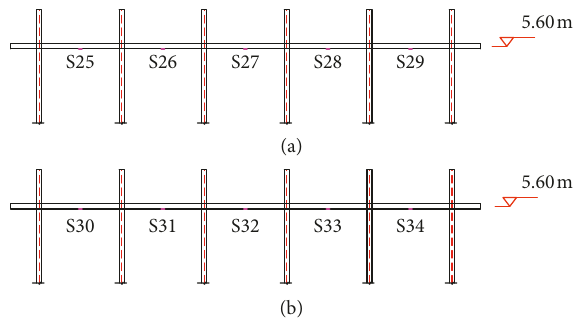
Figure 10: Layout of strain gauges on horizontal rods in Model